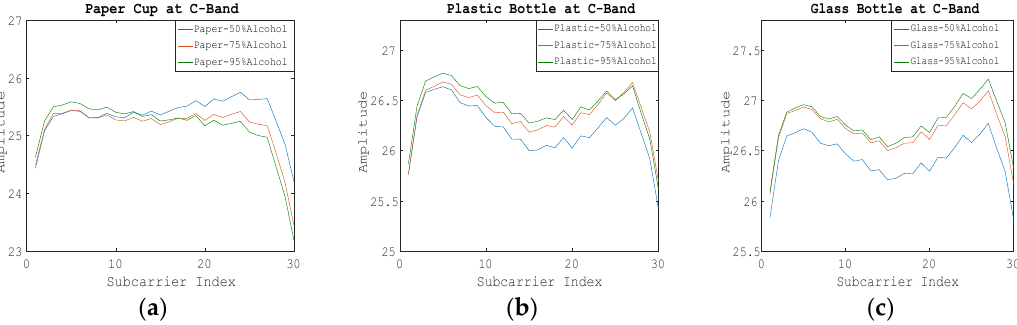
Figure 10. The wireless channel information (WCI) amplitudes of 30 subcarriers corresponding to di ff erent concentrations of alcohol at the C-band by using di ff erent containers. ( a ) Using the paper cup; ( b ) Using the plastic bottle; ( c ) Using the glass bottle.